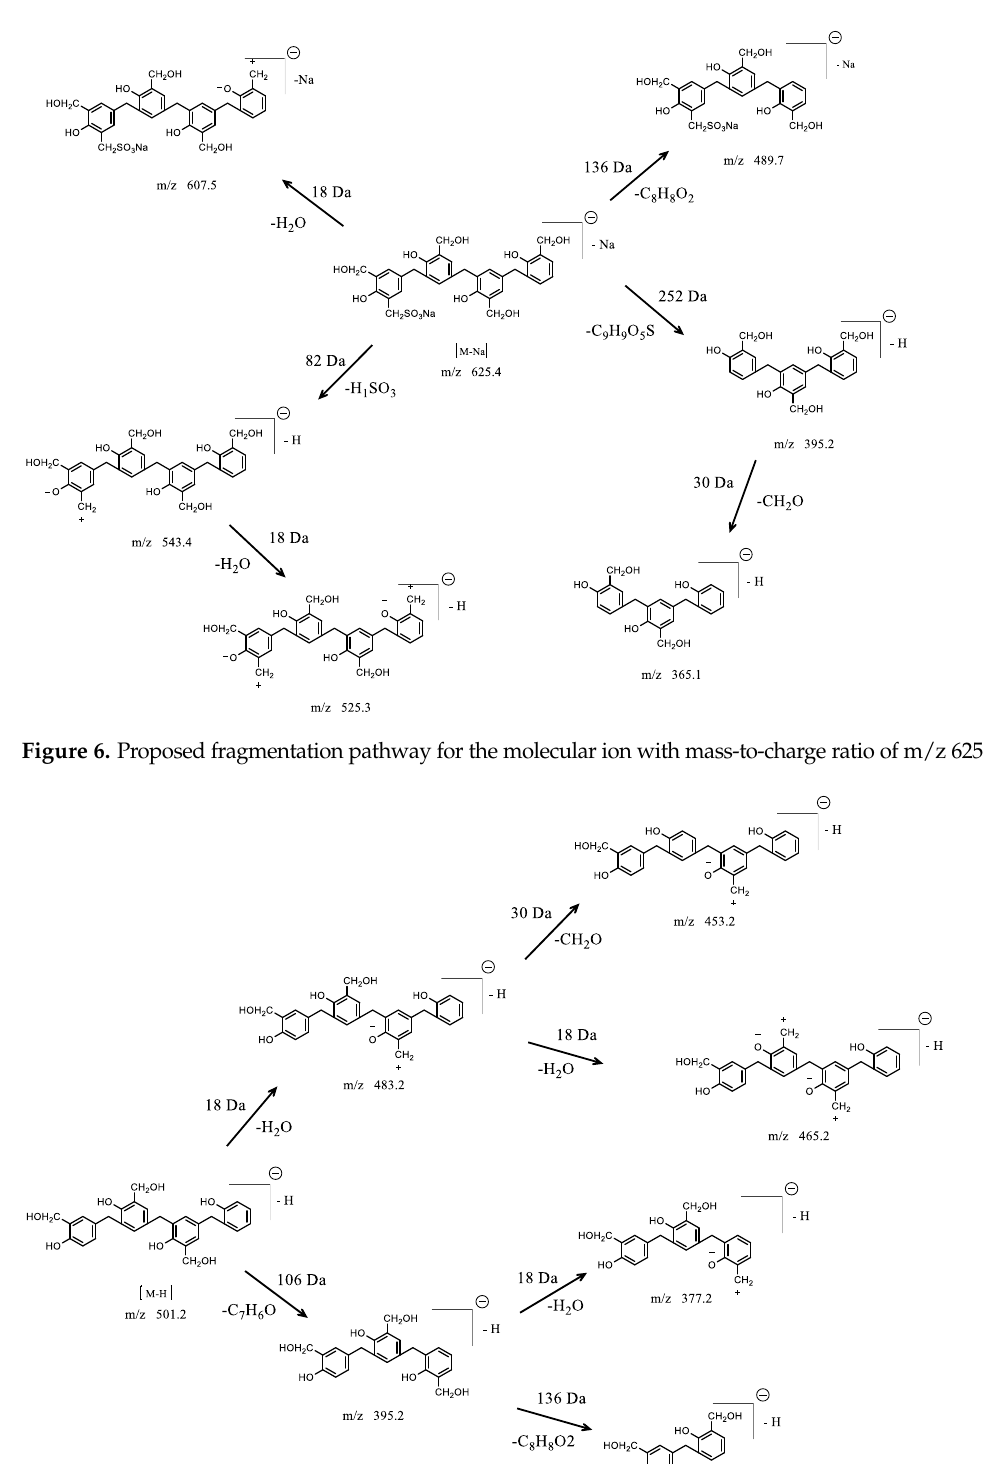
Figure 5. Secondary mass spectra of parent ions m/z 625.4, m/z 501.6 and m/z 595.7